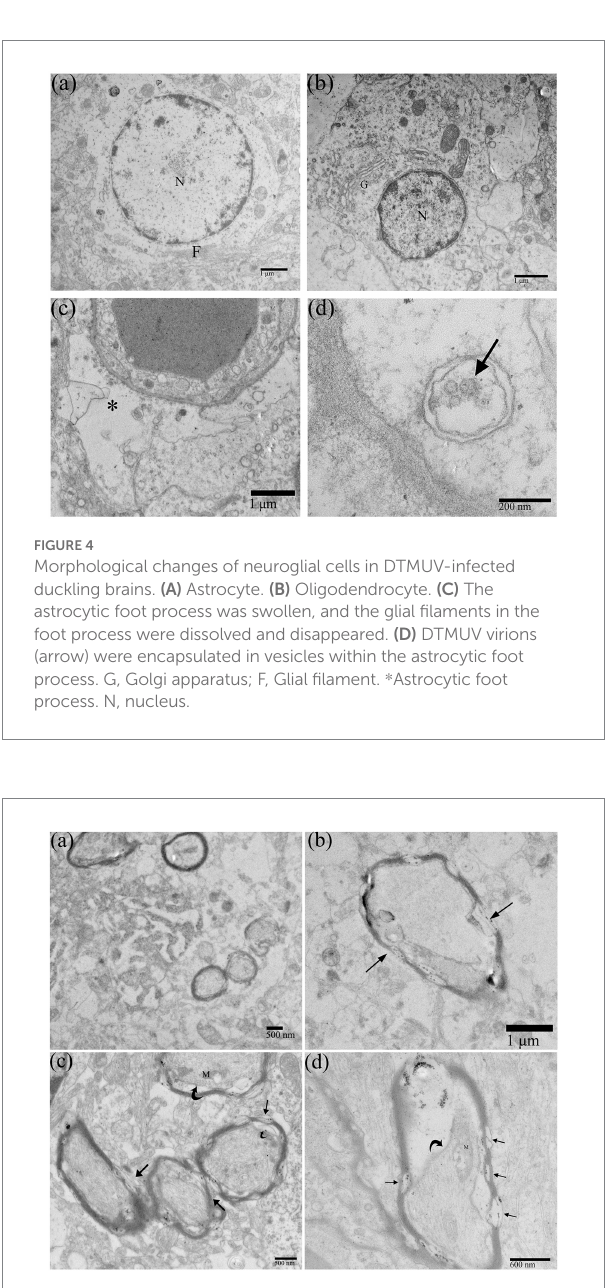
FIGURE 5 Ultrastructural pathological changes of nerve fibers in DTMUV- infected duckling brain. (A) Normal nerve fibers. (B–D) The myelin sheaths of myelinated nerve fibers were split and broken (straight arrow), and the inner axonal mesangium was detached (crooked arrow). The mitochondria within the myelinated nerve fibers were damaged. M,